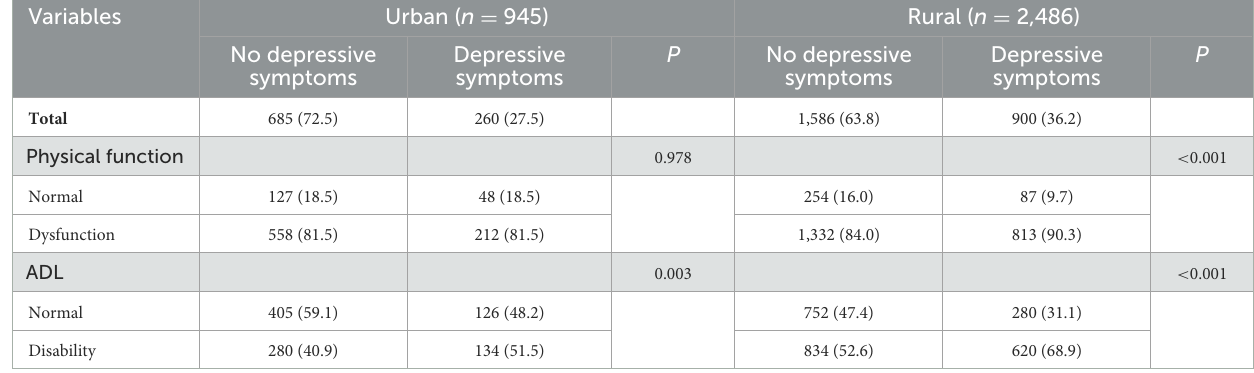
TABLE 2 Depressive symptoms based on urban and rural stratification of physical function and ADL in 2015 [N (%)].